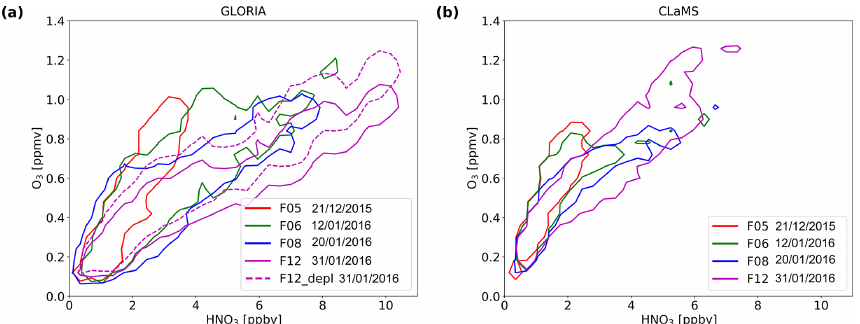
Figure 5. Isolines (contours at 0.02) of the normalized frequency distribution of the O 3 –HNO 3 correlation for December 2015–January 2016 derived from (a) GLORIA measurements and (b) CLaMS simulations. The dashed line for flight 12 includes a compensation of a potential ozone loss of